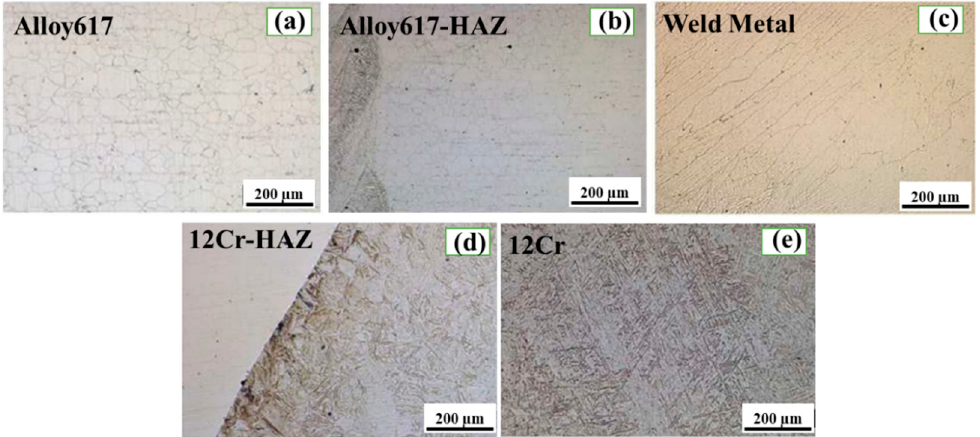
Figure 3. Optical micrographs of important regions after PWHT: ( a ) Alloy 617, ( b ) Alloy617-HAZ, ( c ) Weld metal, ( d ) 12Cr-HAZ and ( e ) 12 Cr.